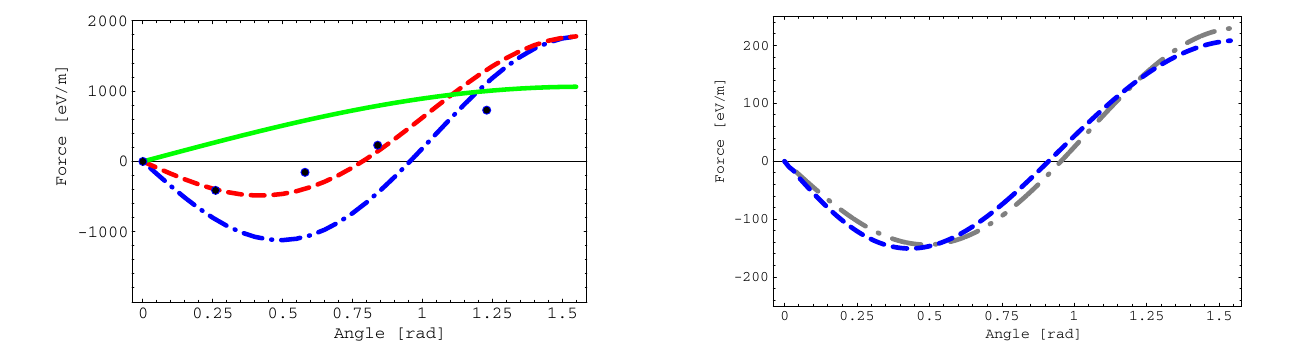
FIG. 7. (Color) Transverse component of the force. Comparison (cid:5) 4 : 2 (cid:6) 10 5 m = s : blue dot-dashed line—Eq. (6); red for (cid:1) e; ? dashed line—Eq. (8); green solid line—Eq. (9); dots with error bars— VORPAL